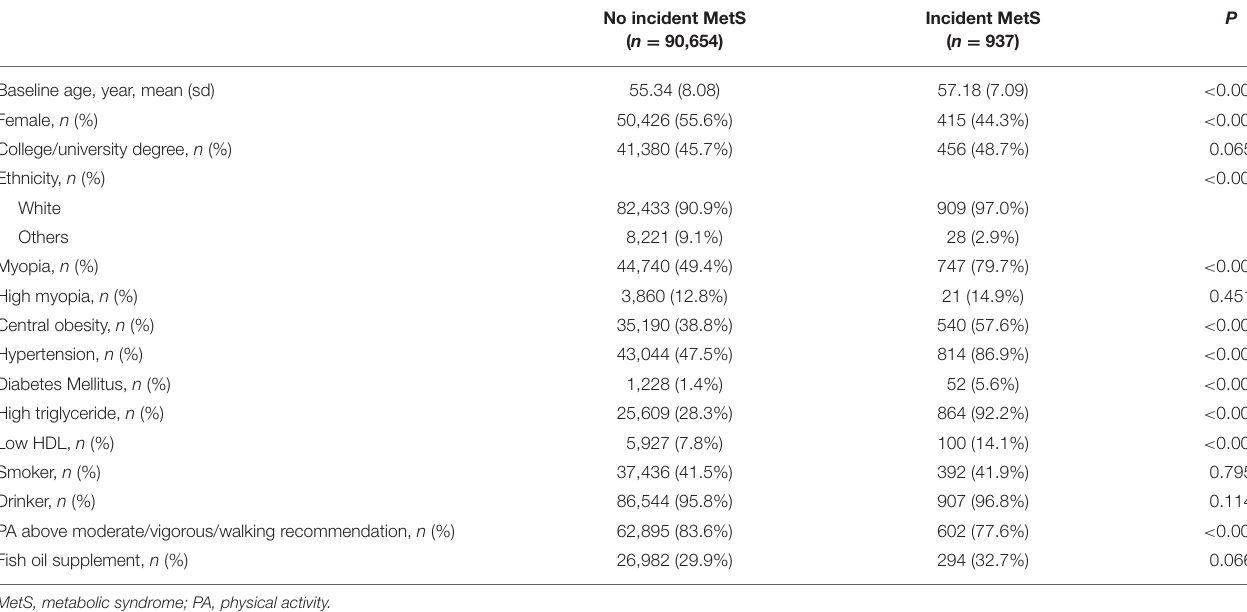
TABLE 2 | Baseline characteristics of participants with and without incident metabolic